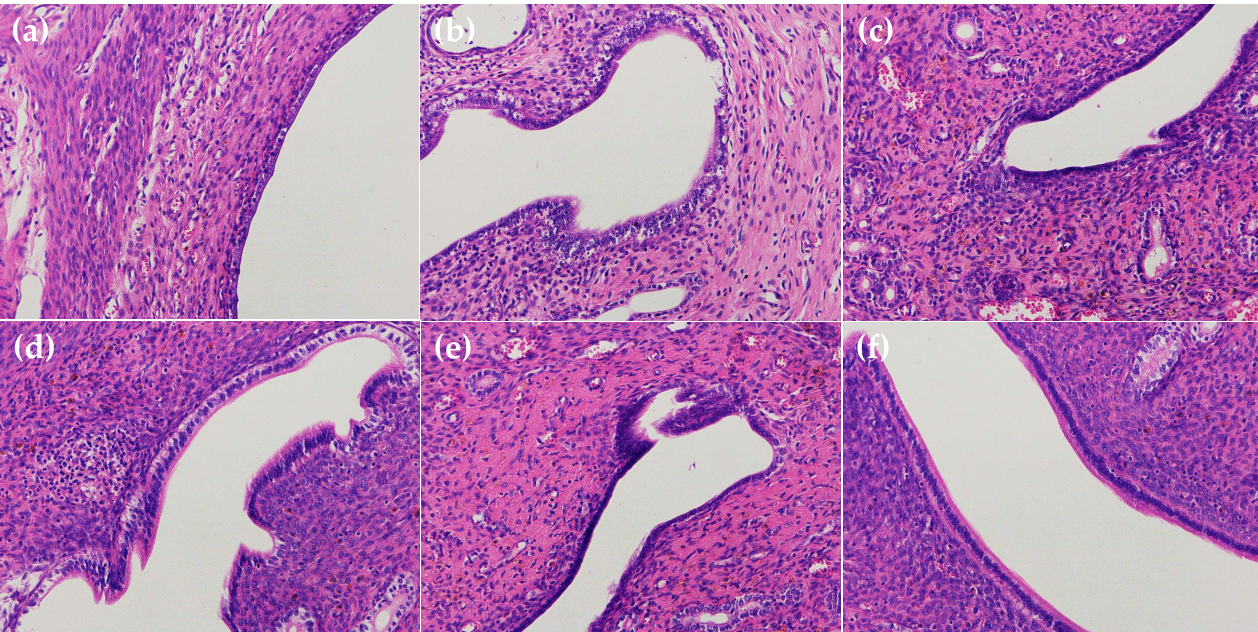
Figure 8. Histopathologic examinations of H & E stained uterine of rats in various groups (200 × ). ( a ) Control group. ( b ) Endometritis group. ( c ) Ceftiofur group. ( d – f ) Luteolin treatment groups (L,